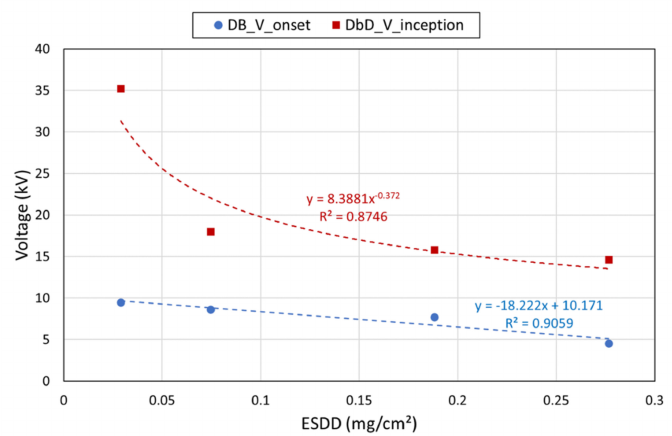
Figure 20. Dry Band (DB) voltage onset and Dry Band Partial Arcs (DBPA) voltage inception vs. pollution level.